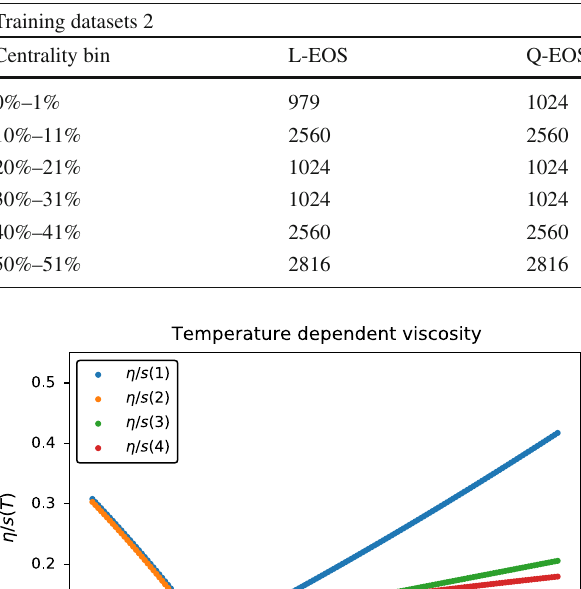
= 137 MeV. The colli- s w